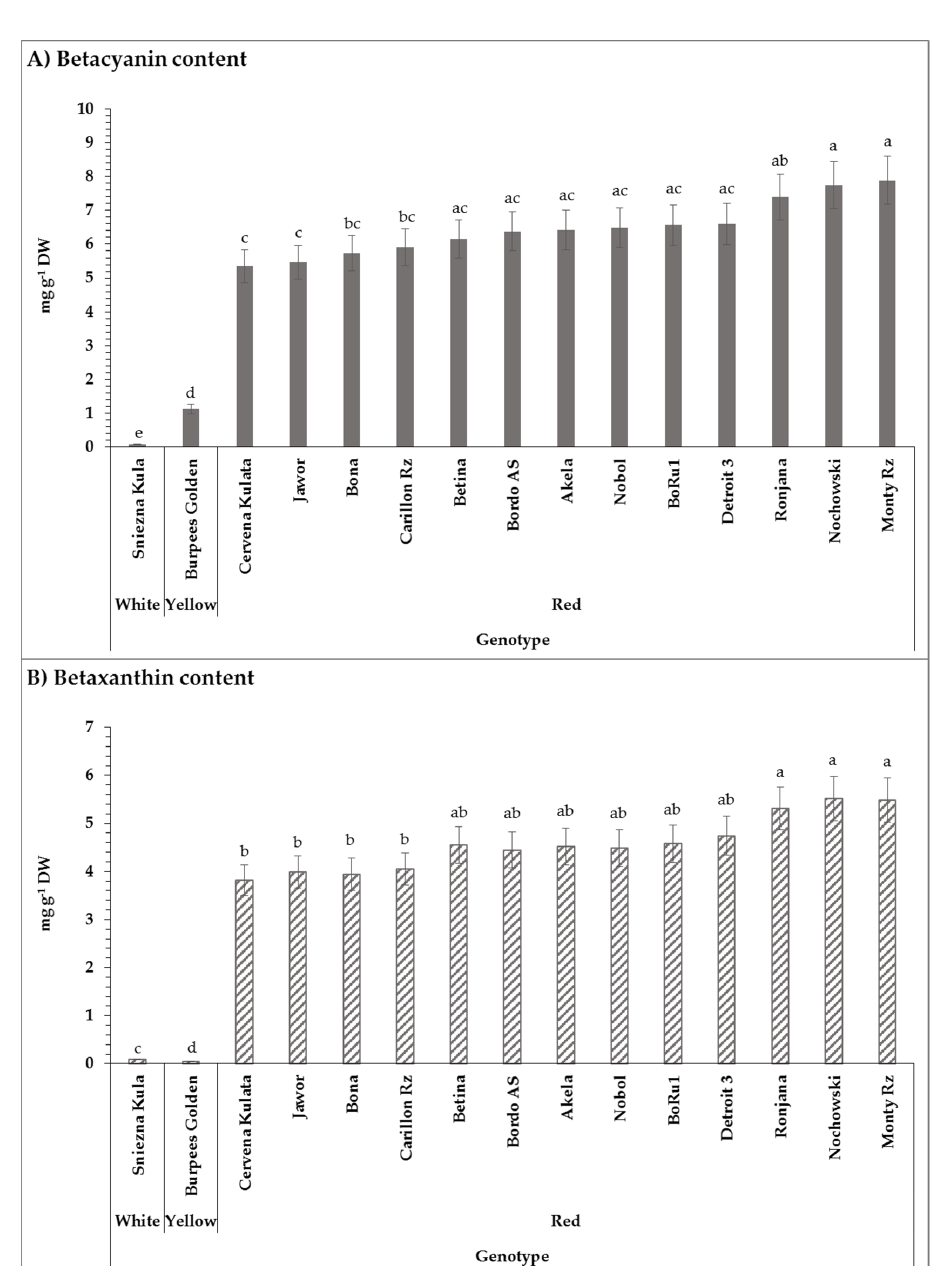
Figure 1. Mean values of ( A ) betacyanin content (mg g − 1 DW) and ( B ) betaxanthin content (mg g − 1 DW) of 15 different genotypes of beetroot grown in three research stations within the trial year 2017 and 2018. Means covered with at least one identical letter were not significantly different from each other.